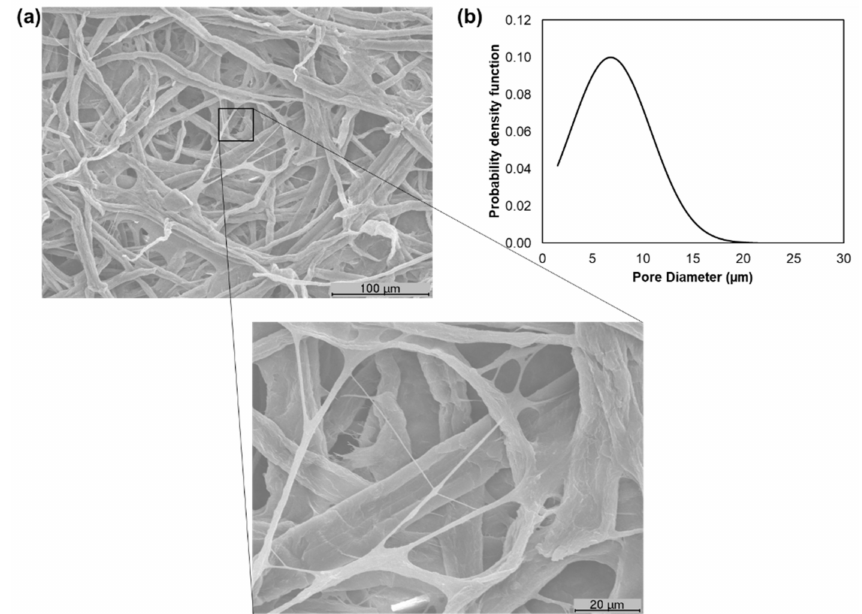
Figure 4. SEM image of tissue formulation 4 (75% eucalyptus pulp + 25% softwood pulp-treated + 2% CBA + 2% CMF) with a high magnification image (1000 × ) where is possible to verify the inter-fiber bonding between CMF and the structure in more detail ( a ) and its pore diameter distribution ( b